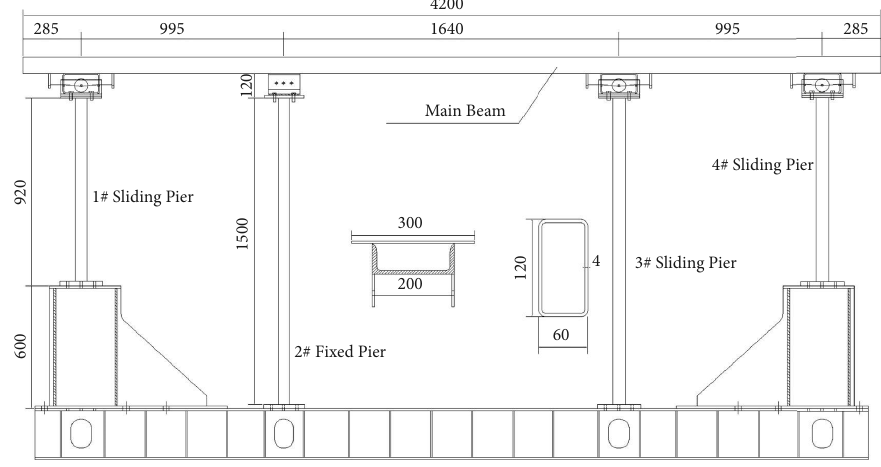
Figure 4: Layout of measuring